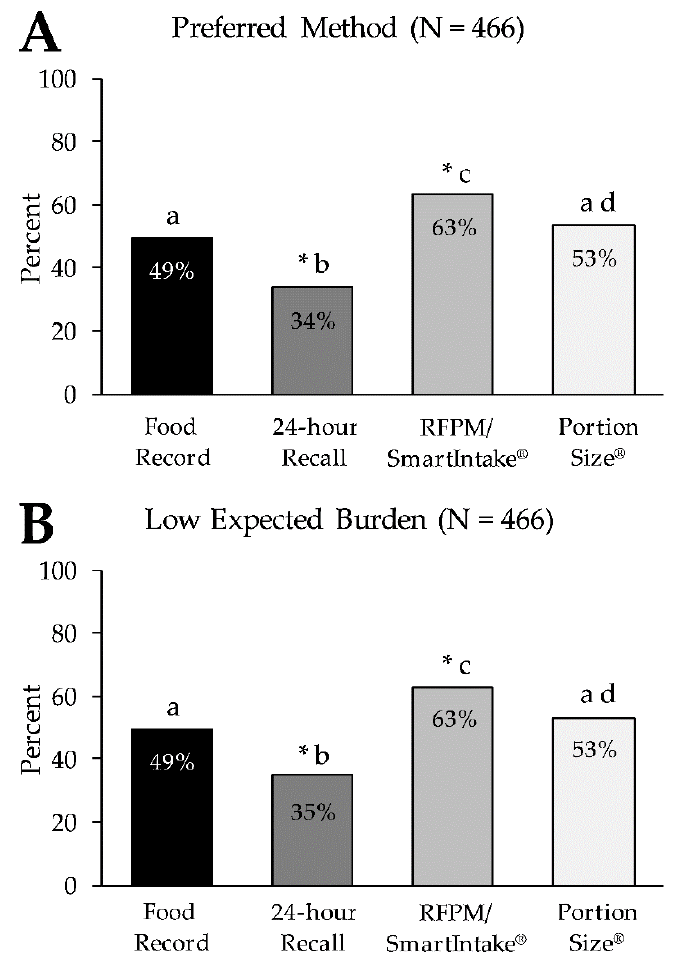
Figure 4. Percentage of participants who rated each method as their preferred method of alcohol consumption assessment (Panel A ) and who rated the expected burden of each method as low (Panel B ). * Denotes a significant difference in ‘not preferred’ for the respective method ( p < 0.001) in the same panel. Letters (a–d) that differ from each other indicate differences between methods ( p < 0.001) in the same panel. RFPM, Remote Food Photography Method. Table 4. Preference, expected burden, and willingness to use the four methods of alcohol consumption assessment (N = 466).